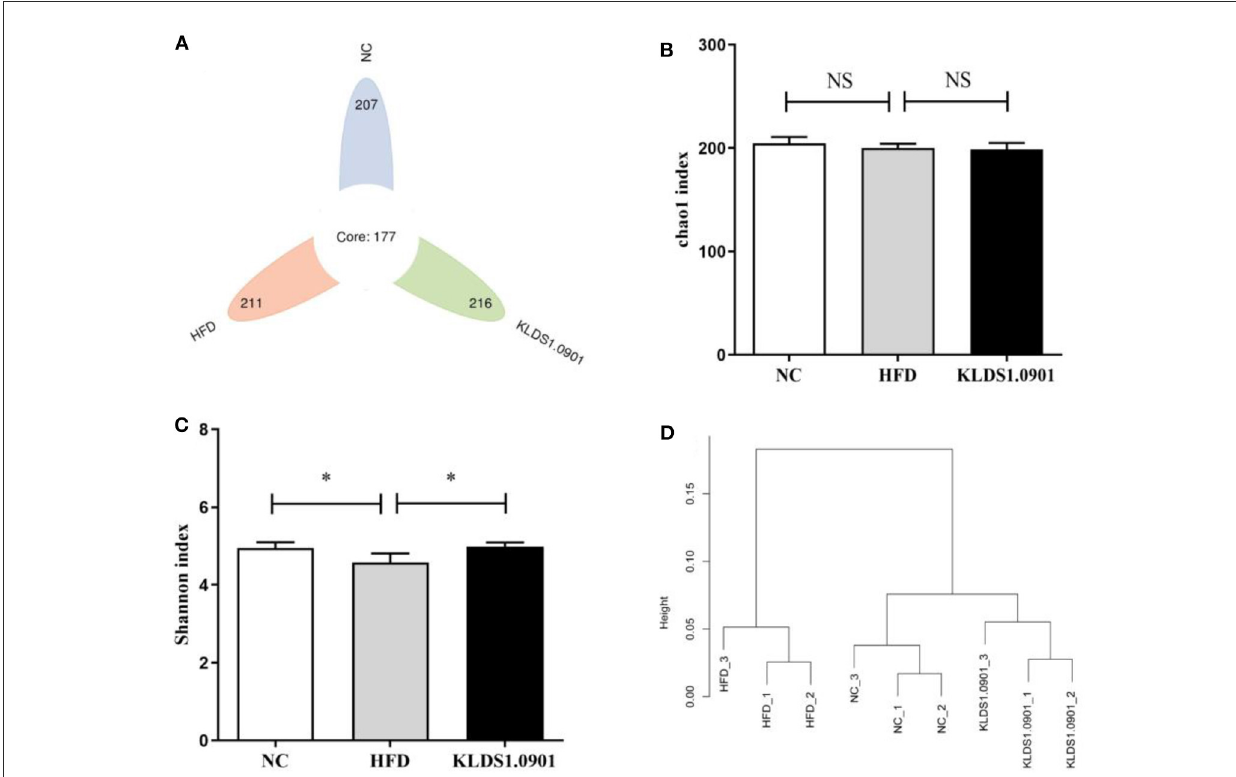
FIGURE7 L. acidophilus KLDS1.0901 administration regulates (A) the number of OTUs, (B) Chao 1 index, (C) Shannon index, and (D) the hierarchical clustering tree of weighted UniFrac distances. NC, normal control group; HFD, high-fat diet group; and KLDS1.0901, L. acidophilus KLDS1.0901 group. Values are expressed as mean ± SD ( n = 8). * p < 0.05 indicated that there was a significant difference when compared with the HFD group. NS indicated that there was no significant difference when compared with the HFD